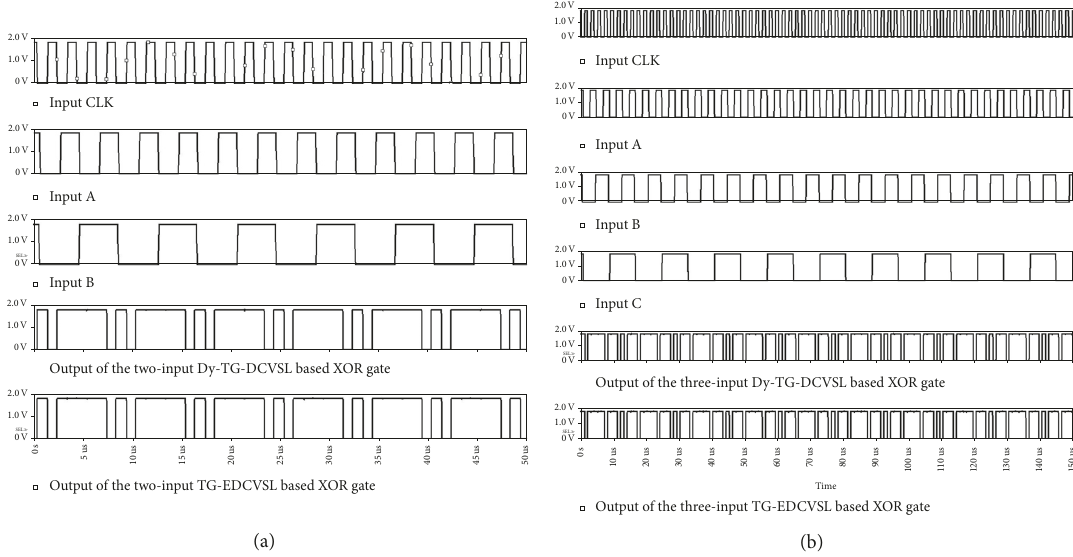
Figure 7: Simulation waveform of Dy-TG-DCVSL and TG-EDCVSL based (a) two-input XOR-XNOR gate and (b) three-input XOR-XNOR gate.